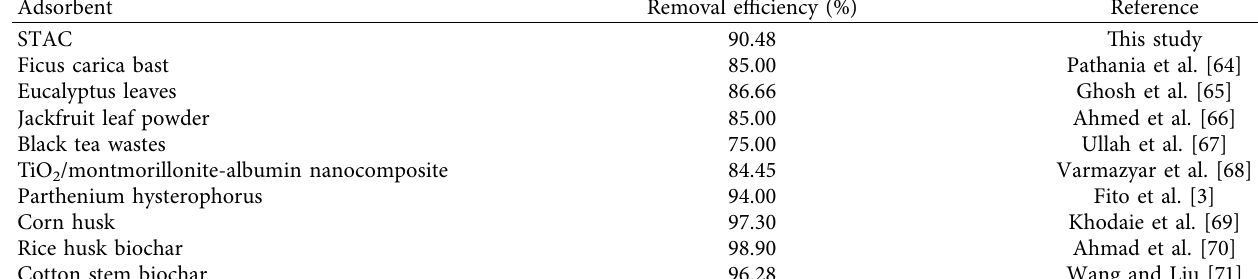
Table 3: Comparison of MB removal efficiency of STAC with other researches.